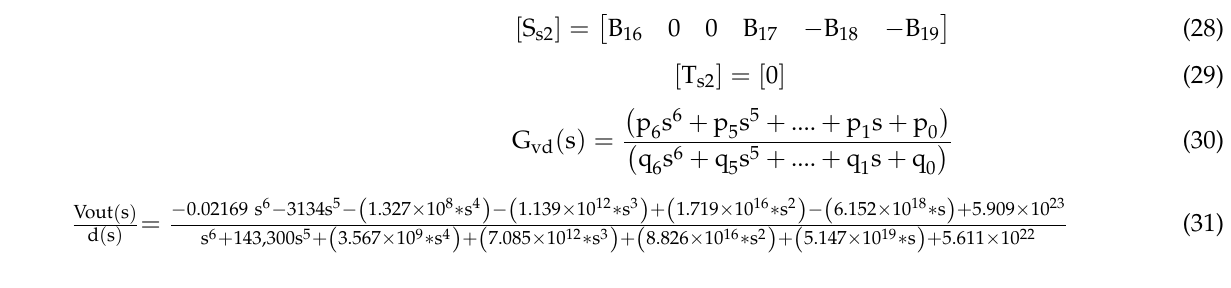
Table 4. SCZEB Converter Design